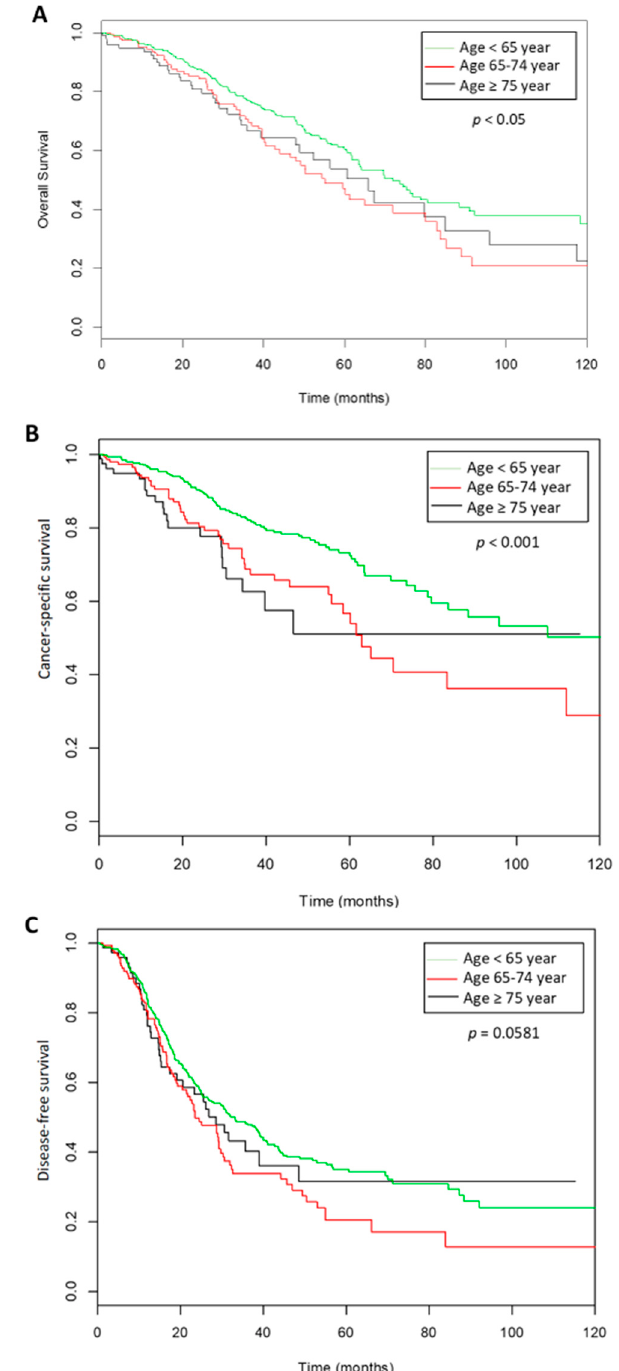
Figure 2. Survival curves according the three groups of ages. ( A ). Overall survival, ( B ). cancer specific survival, ( C ). disease free survival. Table 3. Three-year disease-free survival, cancer-specific survival and overall survival rates (univariate analysis).